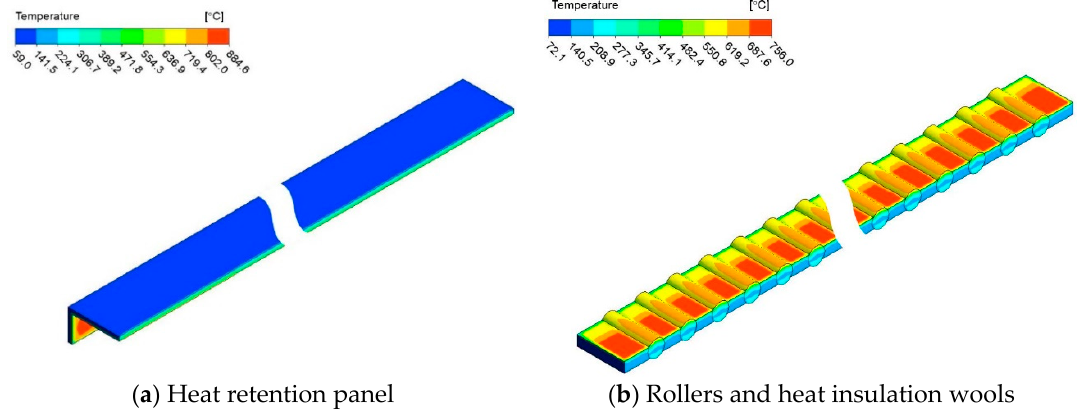
Figure 10. Temperature contours of the traditional passive heat retention panel model (local view).